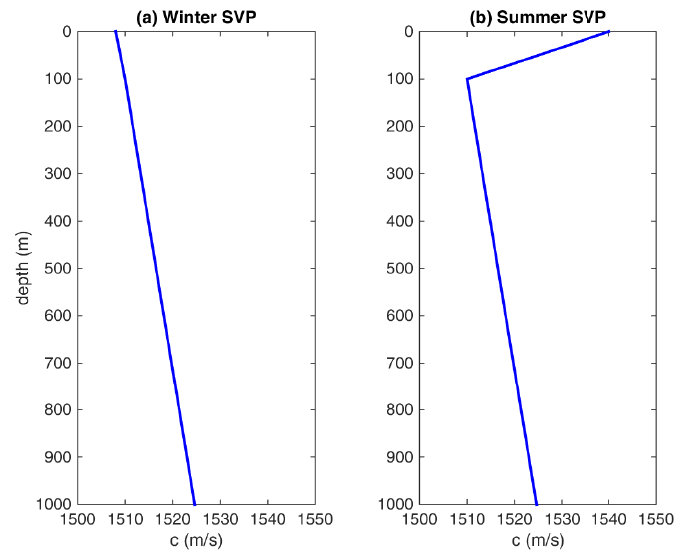
Figure 4. ( a ) Winter sound velocity profile; ( b ) Summer sound velocity profile.